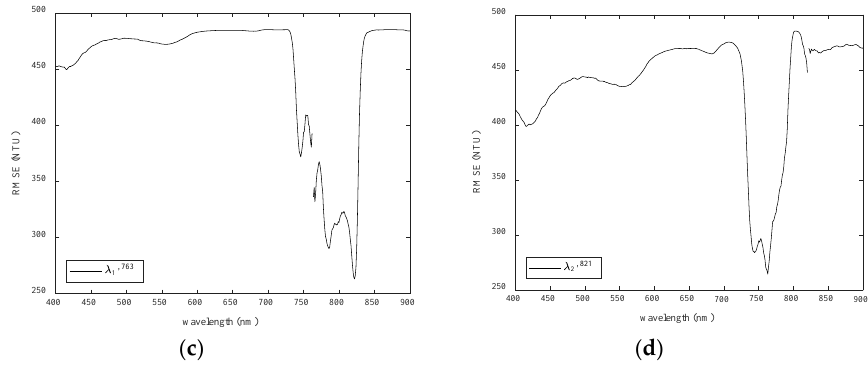
Figure 8. Turbidity results of the two-band model (T2) in SJNU and VDR. ( a ) Correlation coefficient matrix between [ R rs ( λ 8 )/ R rs ( λ 9 )] and measured turbidity; ( b ) optimal correlation between [ R rs (821)/ R rs (763)] and measured turbidity; ( c ) root mean square (RMSE) variation between [ R rs ( λ 1 )/ R rs (763)] and measured turbidity when λ 1 is in the 400–900-nm range; ( d ) RMSE variation between [ R rs (821)/ R rs ( λ 9 )] and measured turbidity when λ 2 is in the 400–900-nm range.